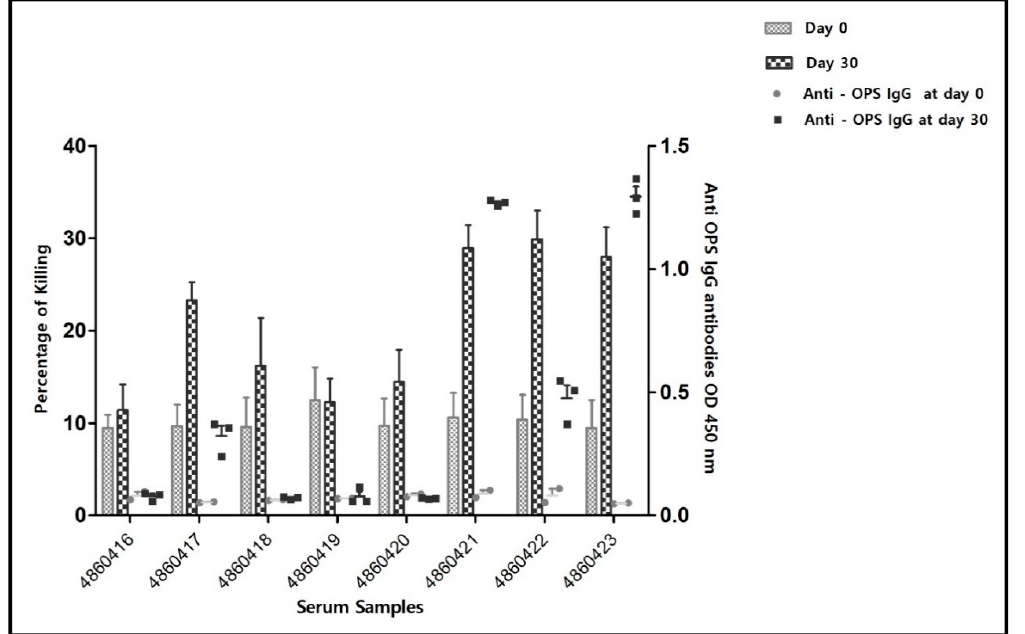
Figure 3. Percentage of cell killing of B. melitensis Rev.1 cells by the individual serum samples on day 0, prior to vaccination and day 30 post-vaccination periods, along with the development of anti- Brucella -OPS i-ELISA titers (results obtained in the second set of experiments). i-ELISA results are of one experiment in triplicates. SBA results represent data of percentage of killing from 4 experi- ments, each including duplicates. Bars stand for standard error of mean.